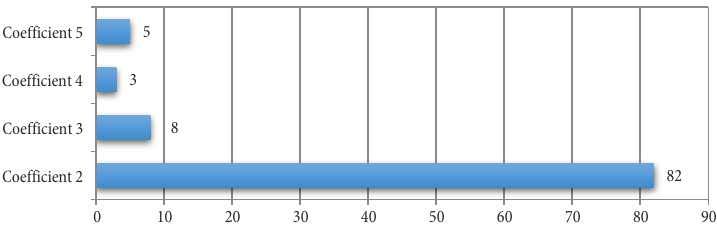
Fig. 4. Structure of respondents according to the amount of the local coefficient